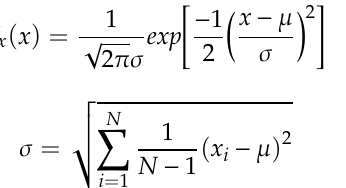
Figure 4. Input Probabilities (discrete PDF integrals).